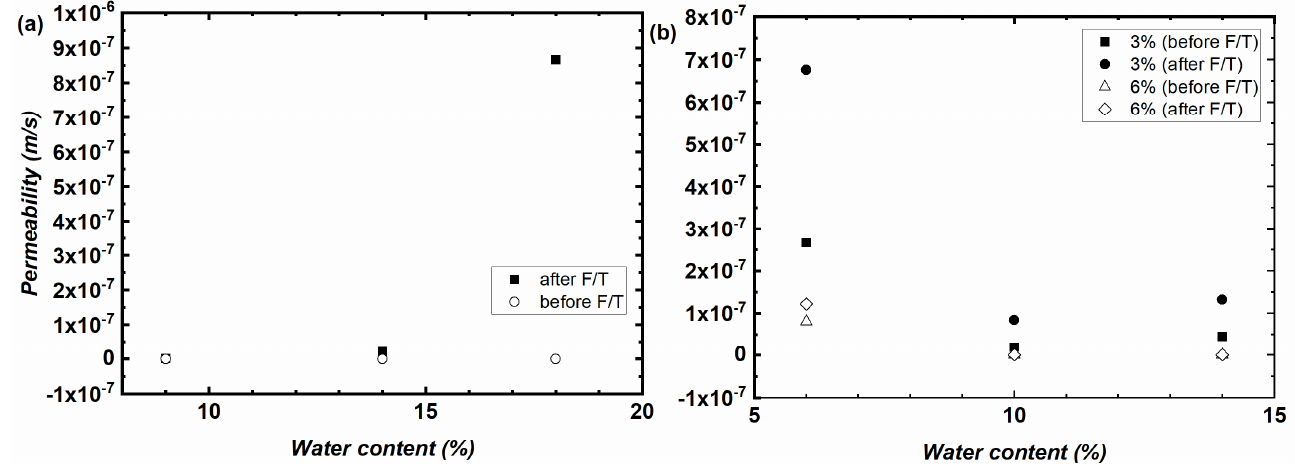
Figure 4. Permeability change caused by F/T cycles: ( a ) permeability versus water content for soilcrete after 12 F/T cycles (adapted from [73]) and ( b ) permeability versus water content for soilcrete after 3 F/T cycles (adapted from [75]).